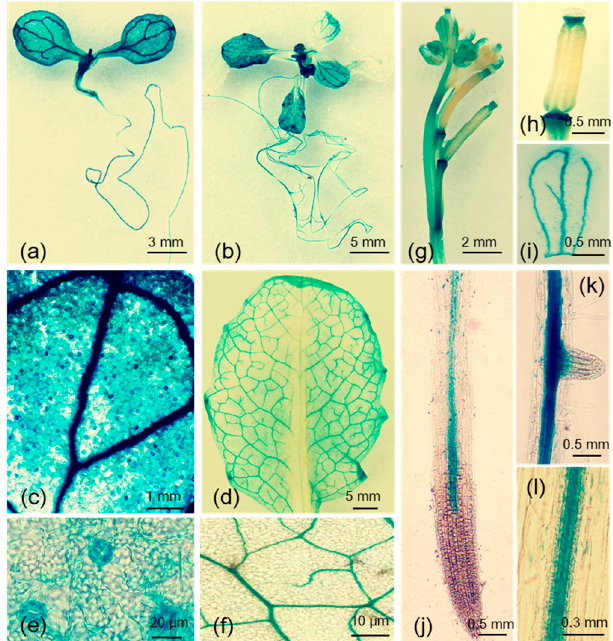
Figure 1. Detection of MYB102 promoter activity by glucuronidase (GUS) staining. GUS activity driven by MYB102 promoter in five-day-old seedlings ( a ), 14-day-old seedlings ( b ), vascular tissues in leaves of five- ( c ) and 14-day-old seedlings ( d ), stomata in leaves of 5-day-old seedlings ( e ), leaves of 14-day-old seedlings ( f ), flowers ( g ), siliques ( h ), petals ( i ), primary roots ( j ), lateral roots ( k ), and vascular tissues in roots ( l ).